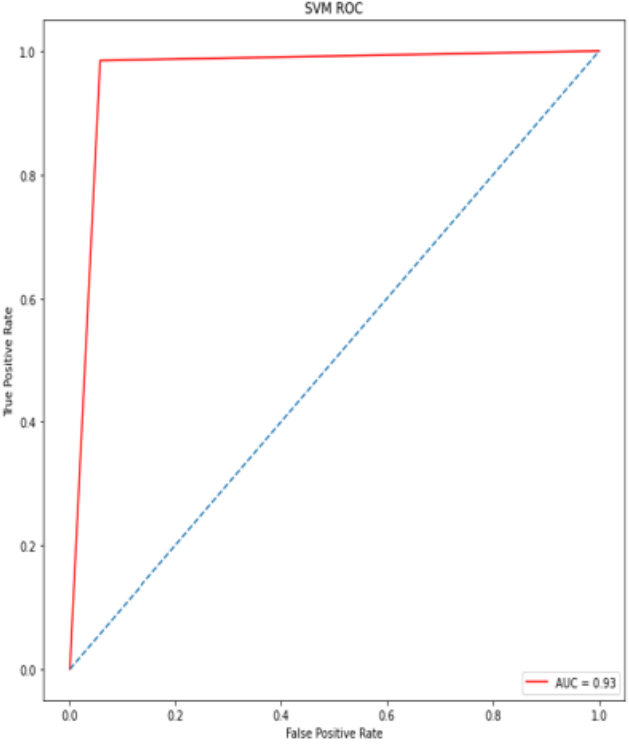
Figure 14. ROC/AUC of Decision tree.